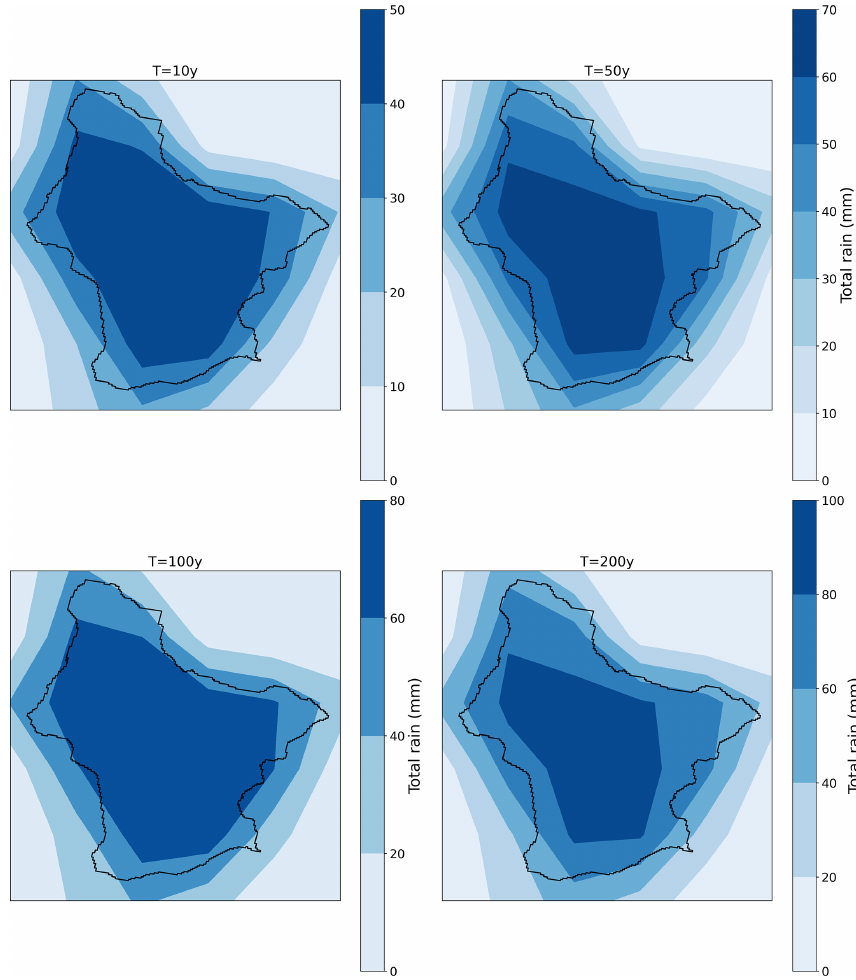
Figure A2. Composite map of rainfall distribution for the 10-, 50-, 100- and 200-year return periods.